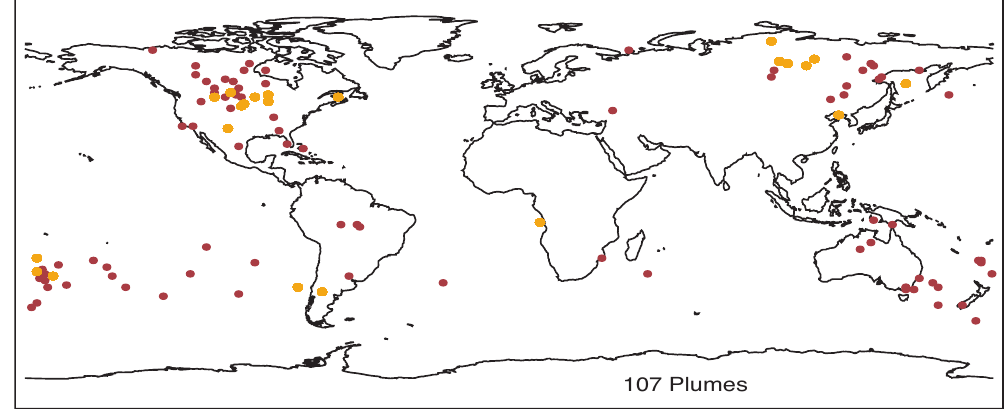
Fig. 1. Locations of AI plumes encountered during the CALIPSO era (1 June 2006 to 13 February 2009). An aerosol plume is defined as containing at least 1 pixel with AI ≥ 7 and at least 3 adjacent pixels with AI ≥ 4. Orange and red symbols represent the cases with and without coincident AI and CALIPSO measurements,